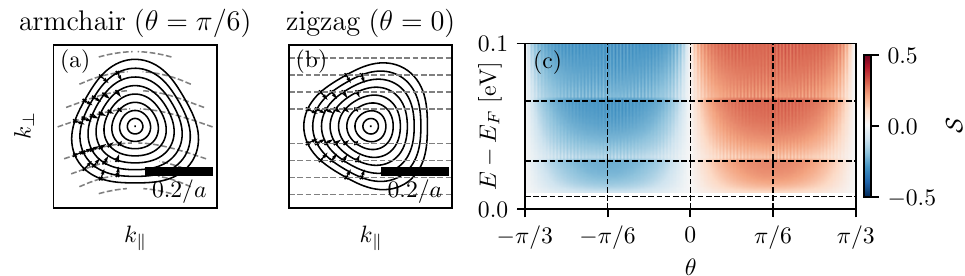
Figure 2: Spin polarization of ballistic currents induced by warping of the Fermi surface. (a, b) Illustration of wave vector selection rules for armchair (a) and zigzag (b) nanoconstraints. The closed lines correspond to Fermi surfaces (“electron pockets”) = 0.1meV. The at different energies E − E in increasing order from E = E to E − E F F F arrows show the direction of the velocity for each of the injected states at selected k ∥ of the lead mode. (c) Computed spin polarization for different crystallographic S orientations θ of the nanoconstraint. The angle θ is measured with respect to zigzag direction. The vertical lines indicate armchair and zigzag orientations, whereas the horizontal lines indicate the population of extra